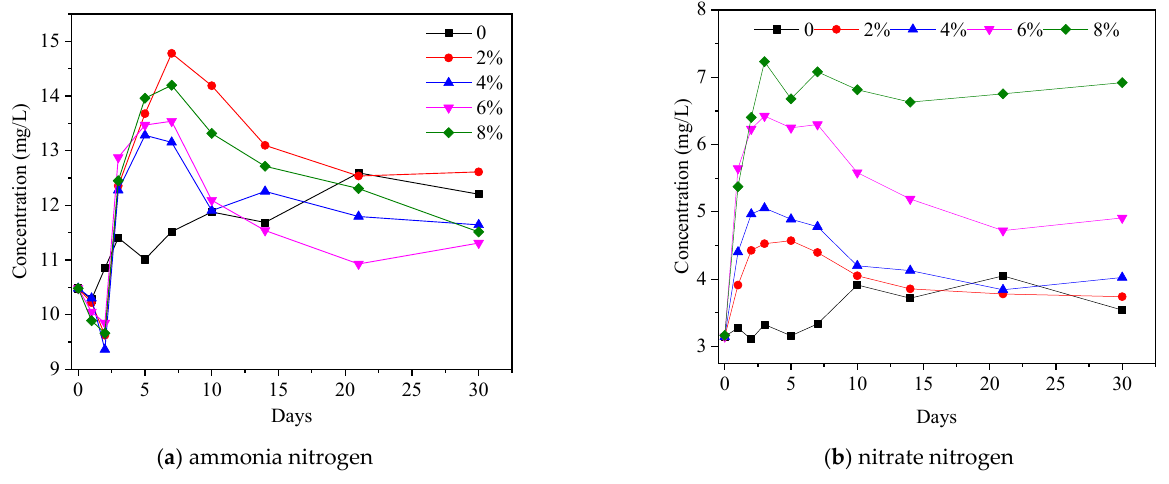
Figure 2. Variation of ammonia nitrogen/nitrate nitrogen concentrations in overlying water.